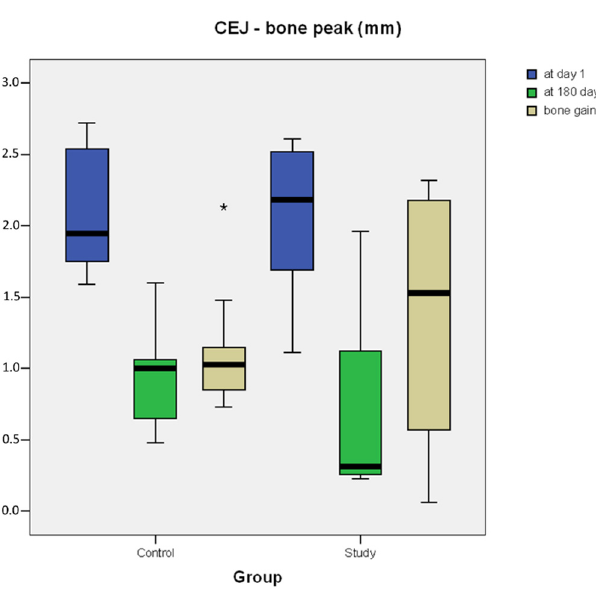
Figure 7. Box plot of radiographic measurements from distal point of M2’s CEJ to bone peak (mm) at T1 and T180. Bone gain (BG). Outlier values at a distance from the median within 1.5 and 3.0 times the interquartile range (IQR) are plotted as circles. Extreme values at a greater distance from the median are plotted as